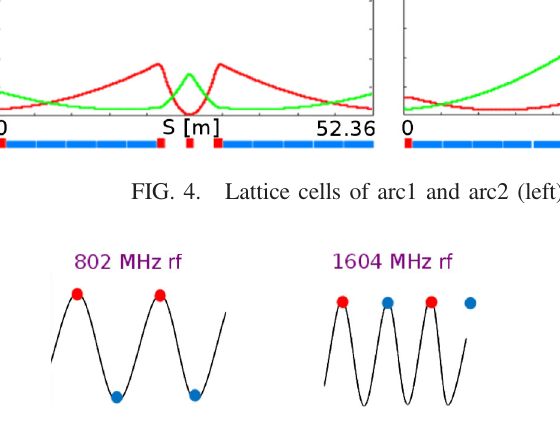
FIG. 5. The second-harmonic rf restores the energy loss in both the accelerating and decelerating passages.